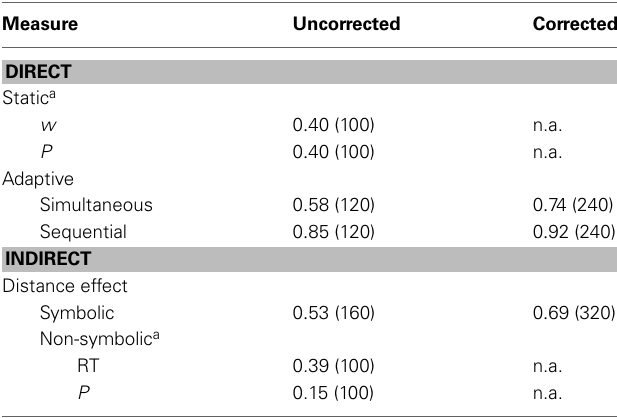
Table 1 | Reliability coefficients and Spearman–Brown corrected reliability coefficients for the different proposed measures of